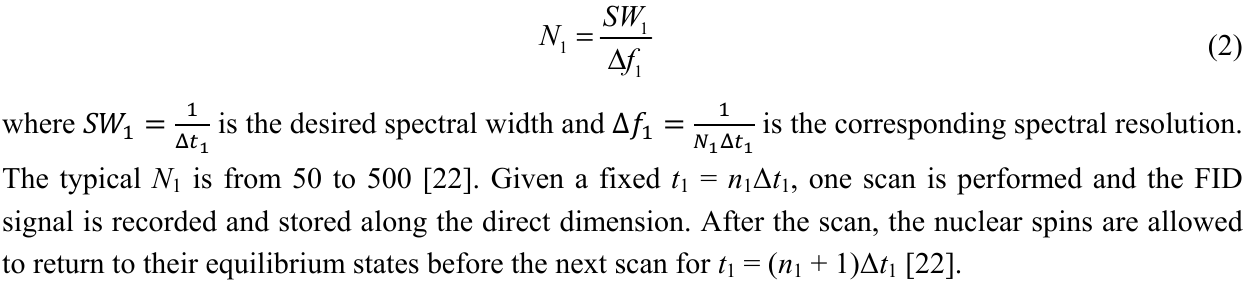
Figure 2. General scheme for 2D NMR